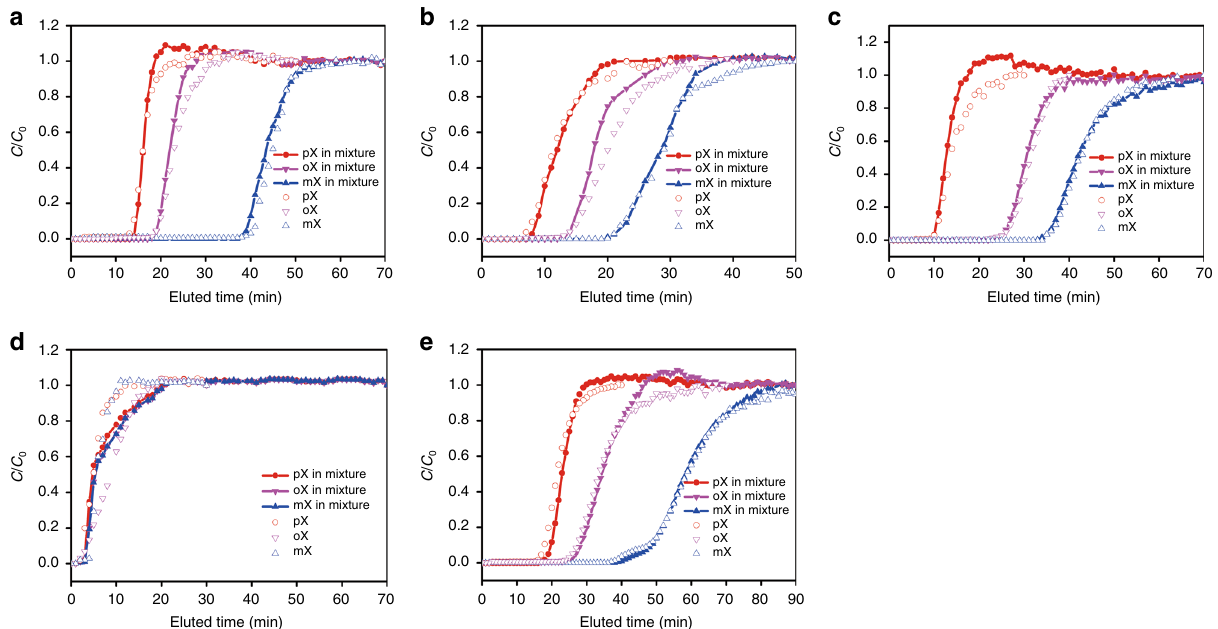
Fig. 3 Ternary breakthrough curves for equimolar mixtures of mixture of o -, m - and p -xylene in different columns. a MFM-300(In), b MFM-300(V), c MFM-300(Fe), d MFM-300(Al) and e , two columns in series comprising MFM-300(In) and MFM-300(V). Measurements were undertaken at 293 K. The solid symbol lines represent ternary breakthrough curves, which were carried out by feeding a ternary equimolar mixture of xylene isomers through the fi xed-bed of MFM-300. The open symbols are the single-component breakthrough curves that were collected by feeding a single-component xylene isomer through the fi xed-bed of